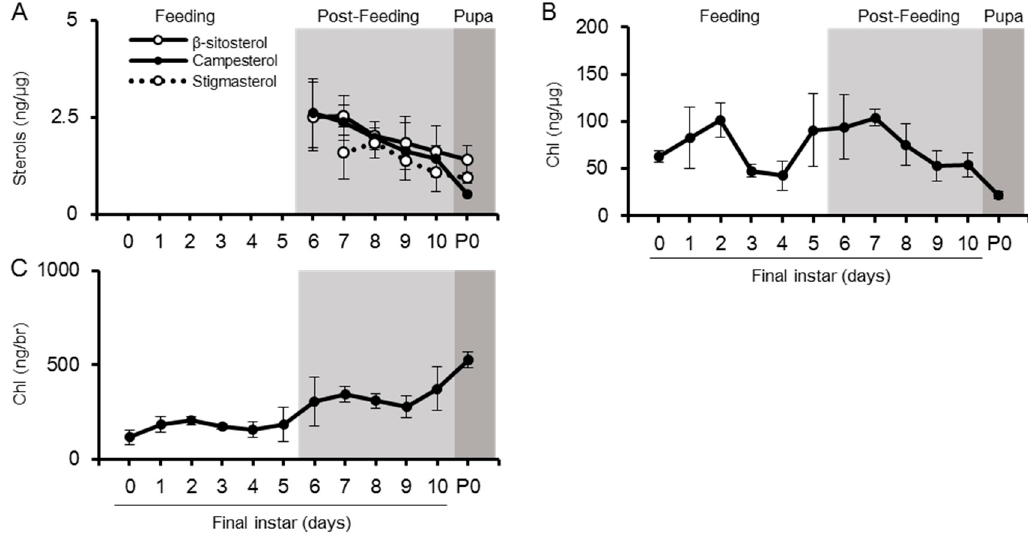
Figure 5. Changes in sterol amount in the brain from final instar to pupal periods. The amount of dietary sterols normalized by protein amounts ( A ), the amount of Chl normalized by protein amounts ( B ), and Chl amounts in a single brain ( C ). Values are mean ± s.d. ( n = 3). P0: pupal stage day